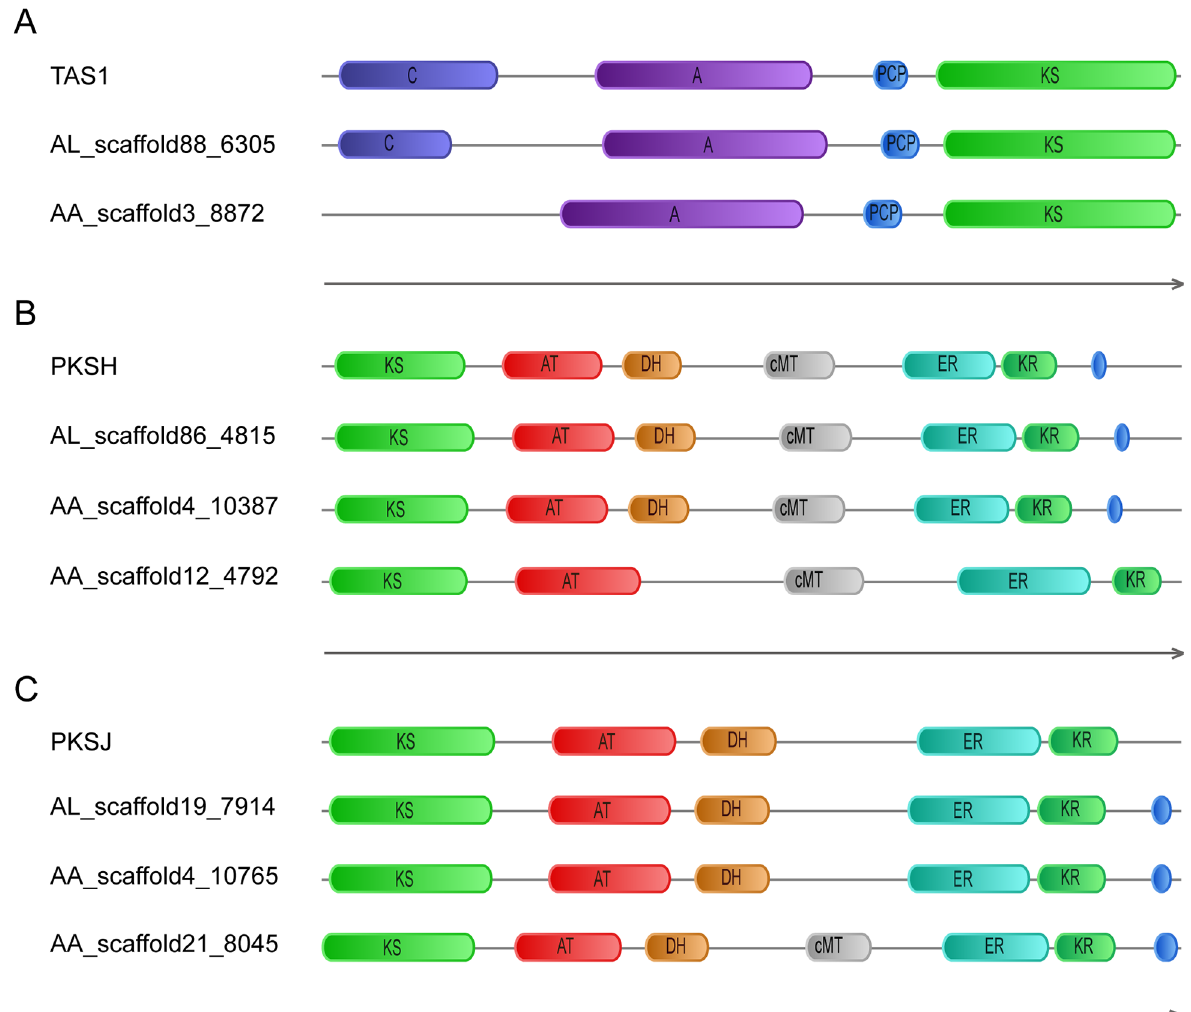
Fig 7. NRPS-PKS homologs in A . longipes cx1 and A . alternata cx2. (A) TAS1 homologous gene in A . longipes cx1 (AL_scaffold88_6305) and A . alternata cx2 (AA_scaffold3_8872) might be required for TeA synthesis. (B) PKSH homologous gene in A . longipes cx1 (AL_scaffold86_4815) and A . alternata cx2 (AA_scaffold4_10387, AA_scaffold12_4792). (C) PKSJ homologous gene in A . longipes cx1 (AL_scaffold19_7914) and A . alternata cx2 (AA_scaffold4_10765, AA_scaffold21_8045). The direction of arrow indicates